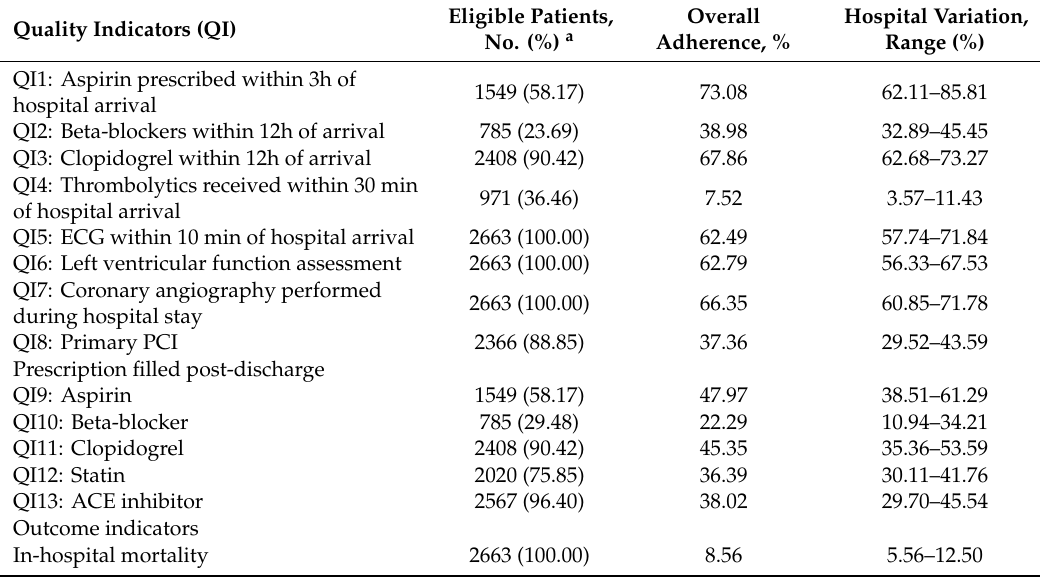
Table 3. Adherence to performance